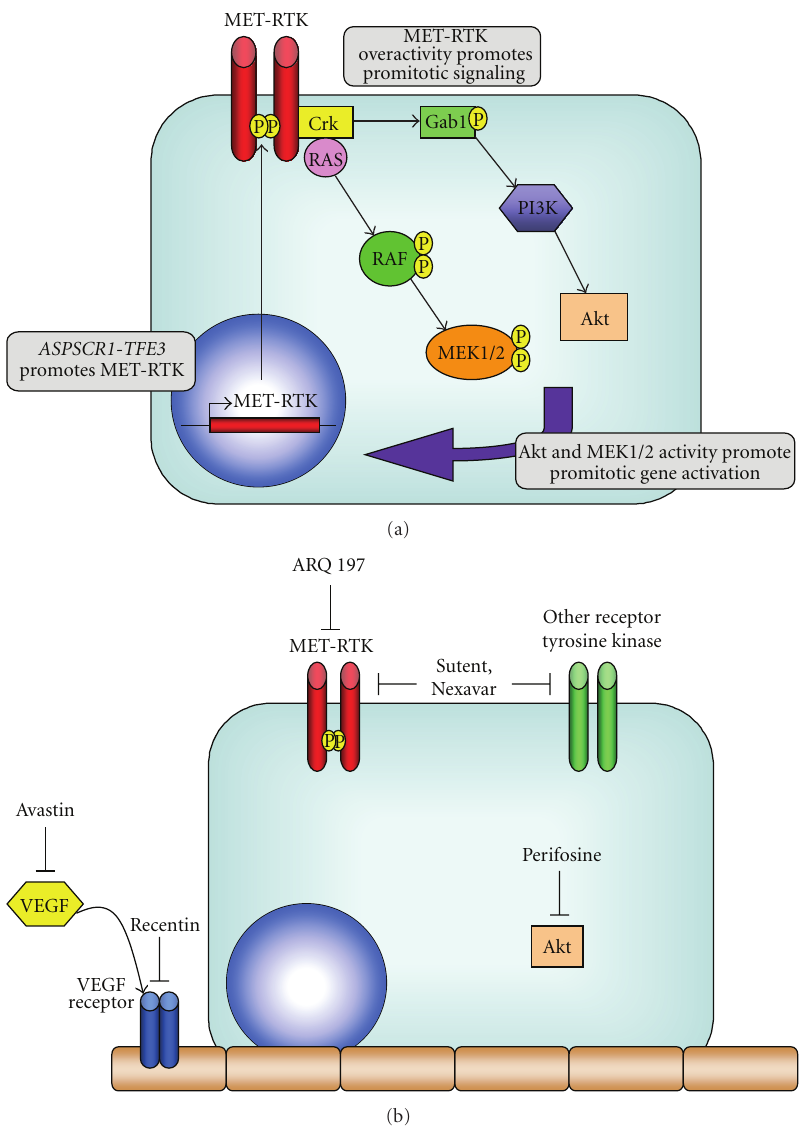
Figure 2: Signaling schematic for ASPS tumors and novel therapeutic targets. (a) Overexpression of the MET tyrosine receptor kinase is induced by the ASPSCR1-TFE3 fusion protein. This leads to intracellular activation of the promitotic growth kinases Akt and MEK1/2; these in turn lead to unchecked cellular proliferation. (b) Targets for novel therapeutics include the VEGF tyrosine kinase receptor and its ligand (Recentin and Avastin, resp.), as well as tumor cell receptor tyrosine kinases (Sutent, Nexavar, and ARQ 197). Perifosine is a unique inhibitor of the Akt